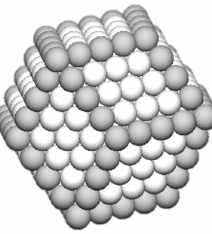
Figure 9. Equilibrium morphology for nanoparticles of bcc metals. A 369-atom dodecahedron with 12 identical faces. Reproduced with permission from